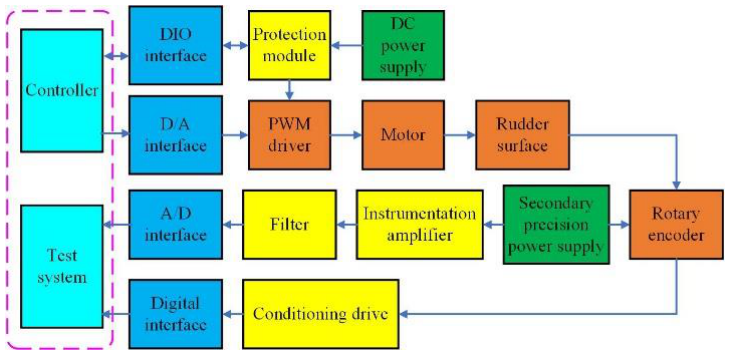
Figure 9. Electric rudder system test platform.